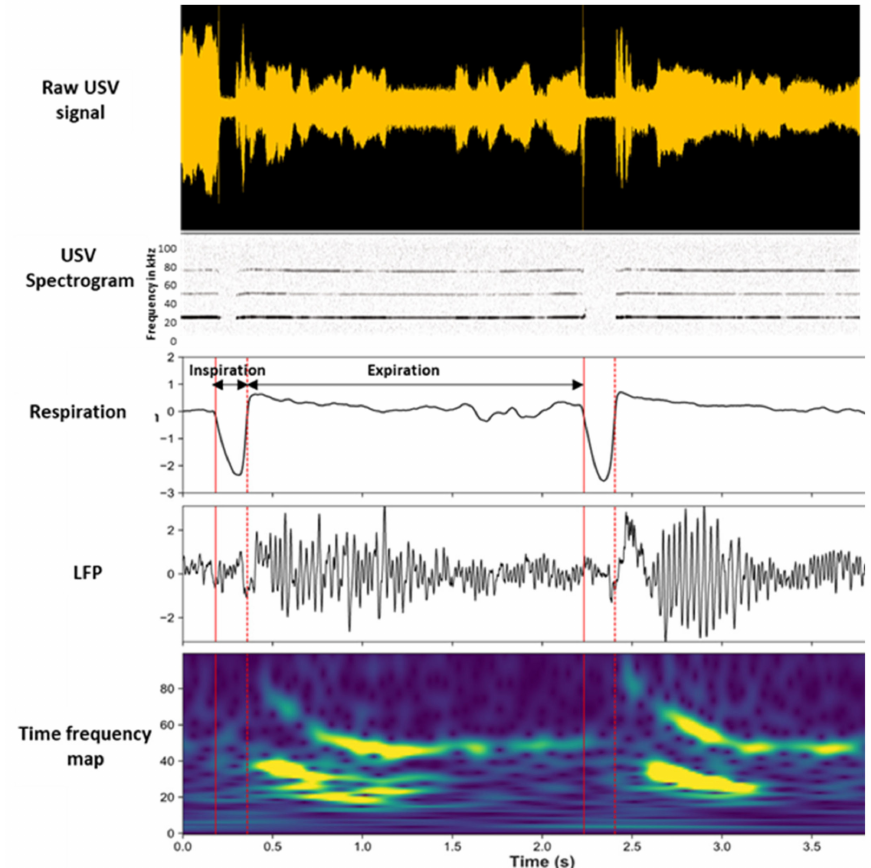
Figure 3. Modulation of beta and gamma oscillation power by the phase of the respiratory cycle. Individual traces represent, from the top, the raw USV calls, USV spectrogram, respiratory signal, raw local field potential (LFP) signal recorded in the piriform cortex (PIR), and its time frequency map (y-axis: LFP signal frequency in Hz; x-axis: time in milliseconds). Adapted from [158], visual